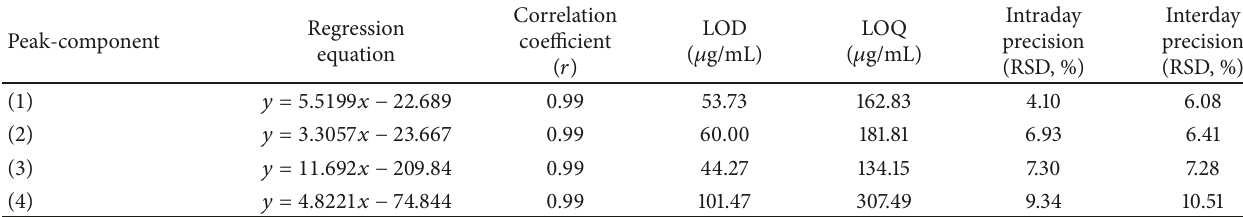
Table 1: Validation parameters for the four peaks-components in hexane fraction from Leucophyllum frutescens leaves. Peak-component